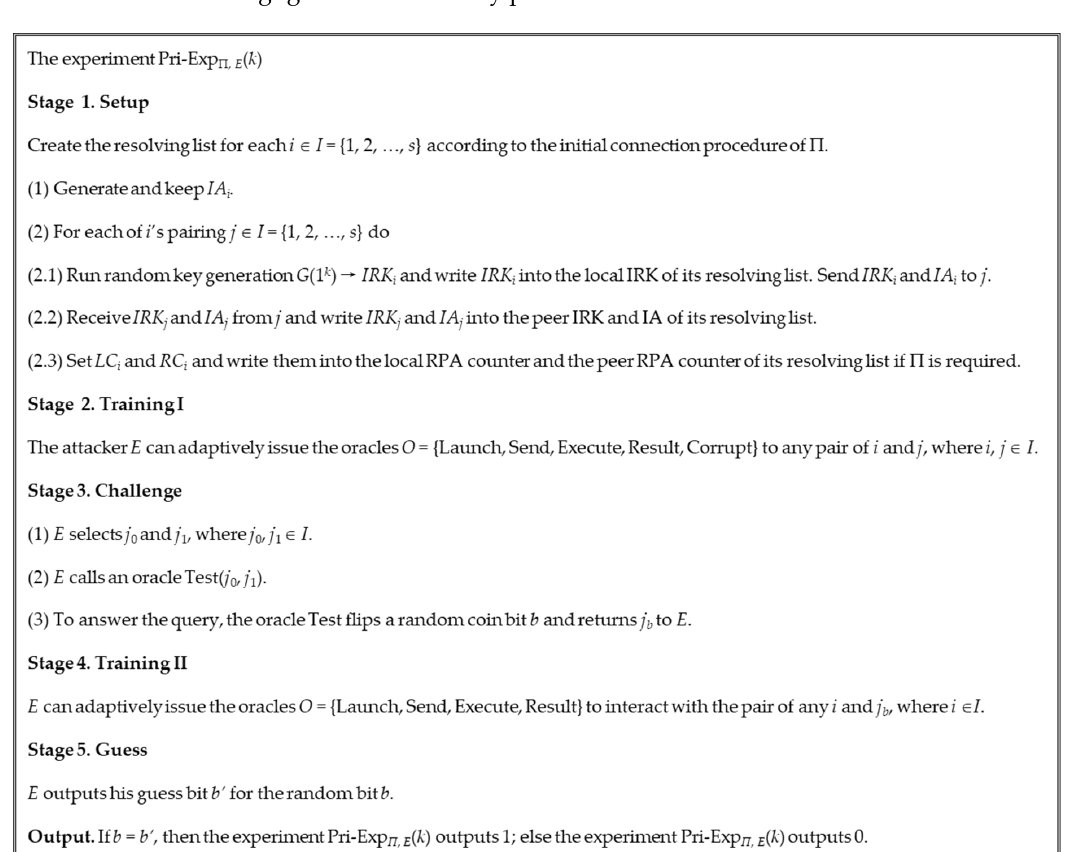
Figure 12. Privacy experiment for RPA mechanisms.